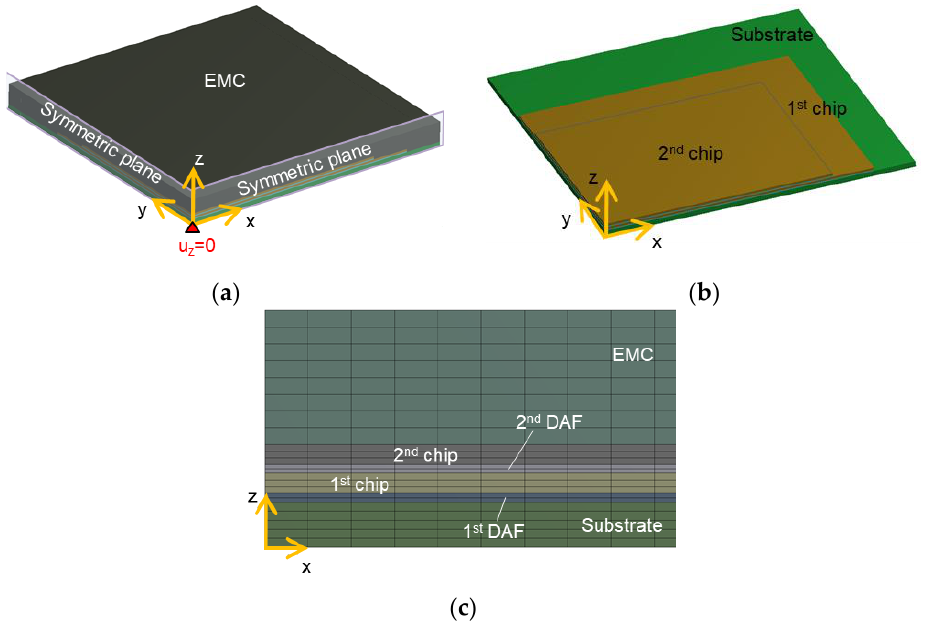
( b ) Figure 2. TFBGA package: ( a ) cross-sectional view and ( b ) bottom view.